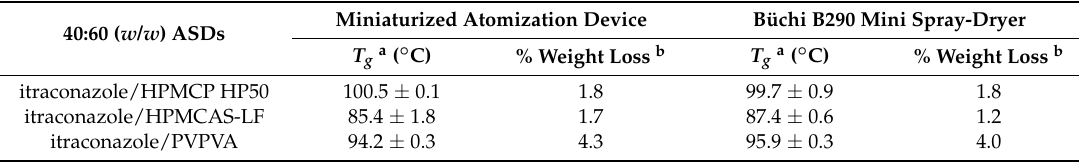
Table 2. Summary of T g values and percentage of weight loss of 40:60 ( w / w ) binary amorphous solid dispersions (ASDs) of itraconazole generated at both screening and laboratory scales. 40:60 ( w / w ) ASDs